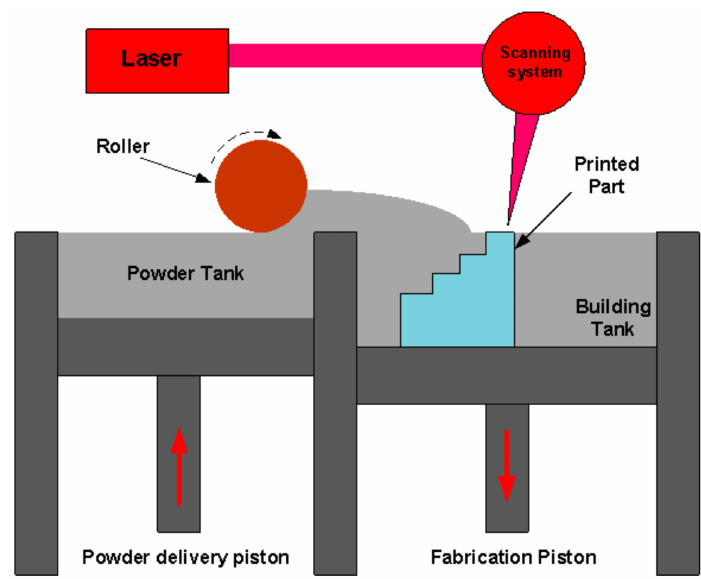
Figure 1. Schematic representation of the PBSLP